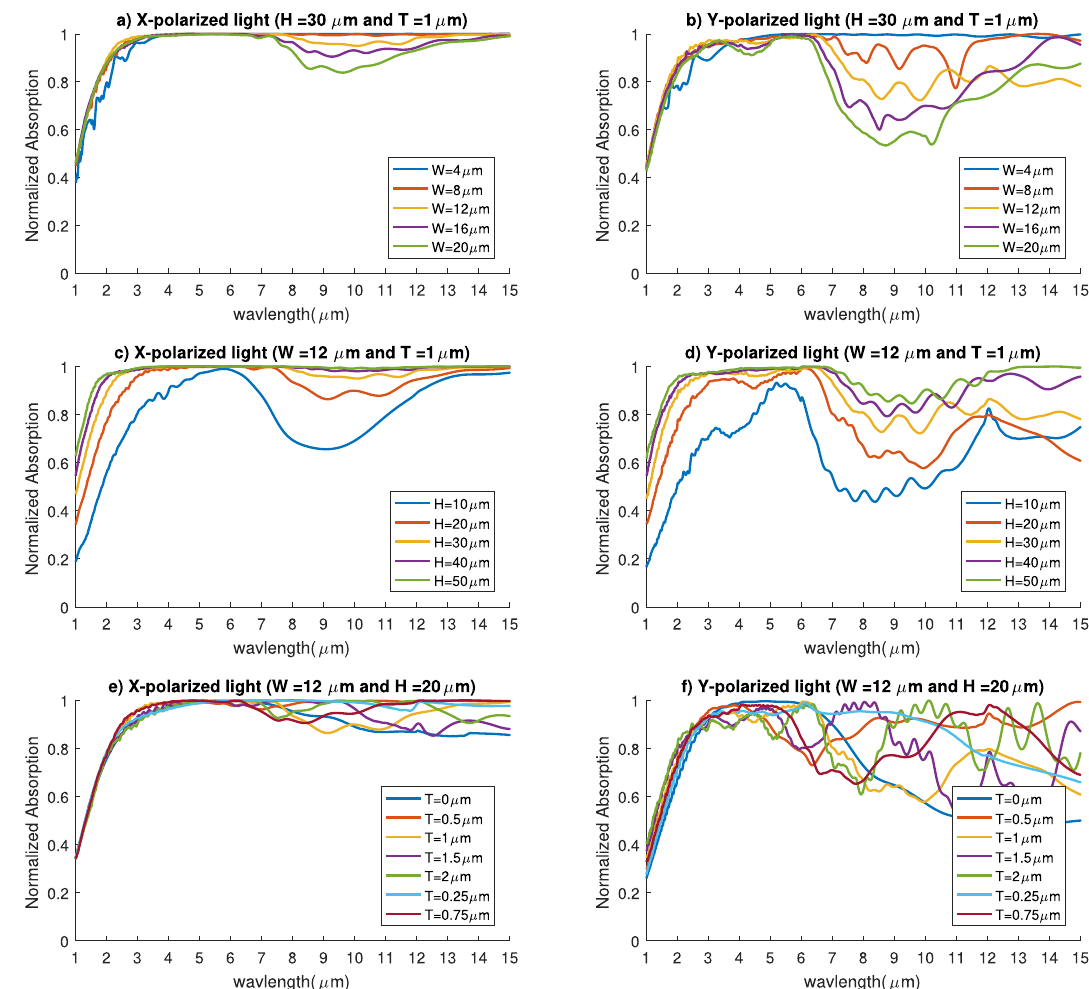
Figure 4. Absorption spectrum for different nanoprism dimensions. ( a ) Absorption of x-polarized waves for different widths, ( b ) Absorption of y-polarized waves for different widths, ( c ) Absorption of x-polarized waves for different heights, ( d ) Absorption of y-polarized waves for different heights, ( e ) Absorption of x-polarized waves for different silicon coating thickness, ( f ) Absorption of y-polarized waves for different silicon coating